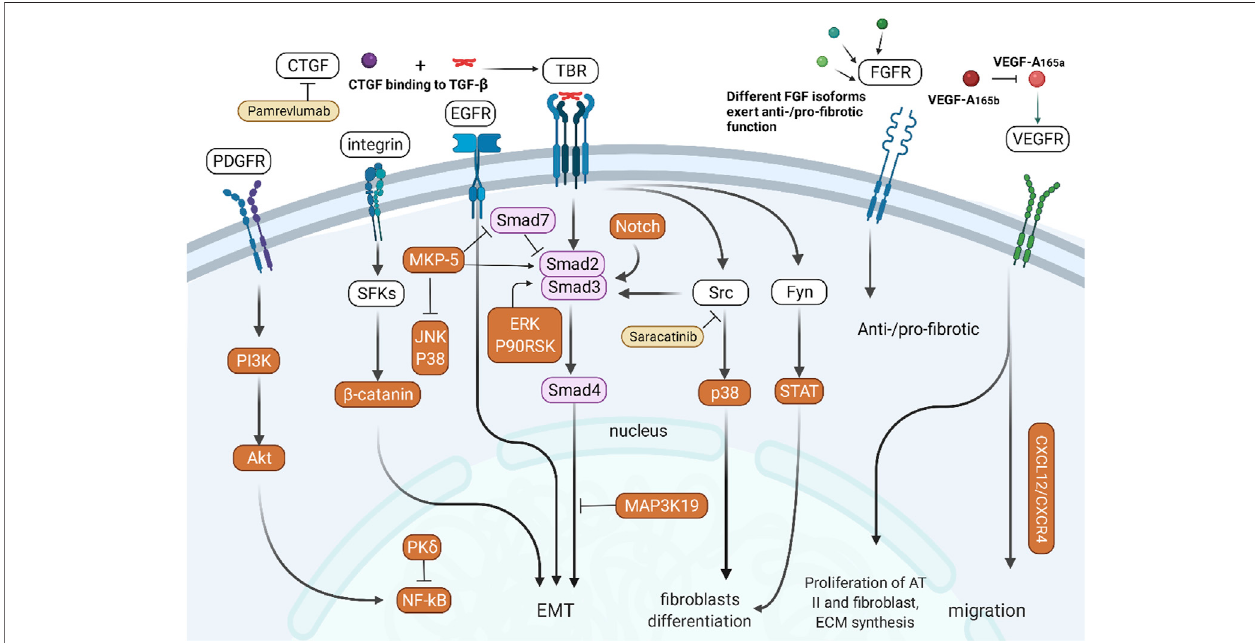
FIGURE4| CrosstalkbetweenRTK/non-RTKandothersignalingpathways.PDGFRactivatesNF- κ BsignalingthroughthePI3K/Aktpathway.Integrinsparticipate in EMTofepithelialcellsthroughSFK/ β -catenin-mediated signaling. TGF- β /SmadsignalinginteractswiththeCTGF,Src, Fyn, andNotch pathwaystoparticipateinEMT in epithelial cells. Different subtypes of FGF and VEGF have different pro- or anti fi brotic effects.